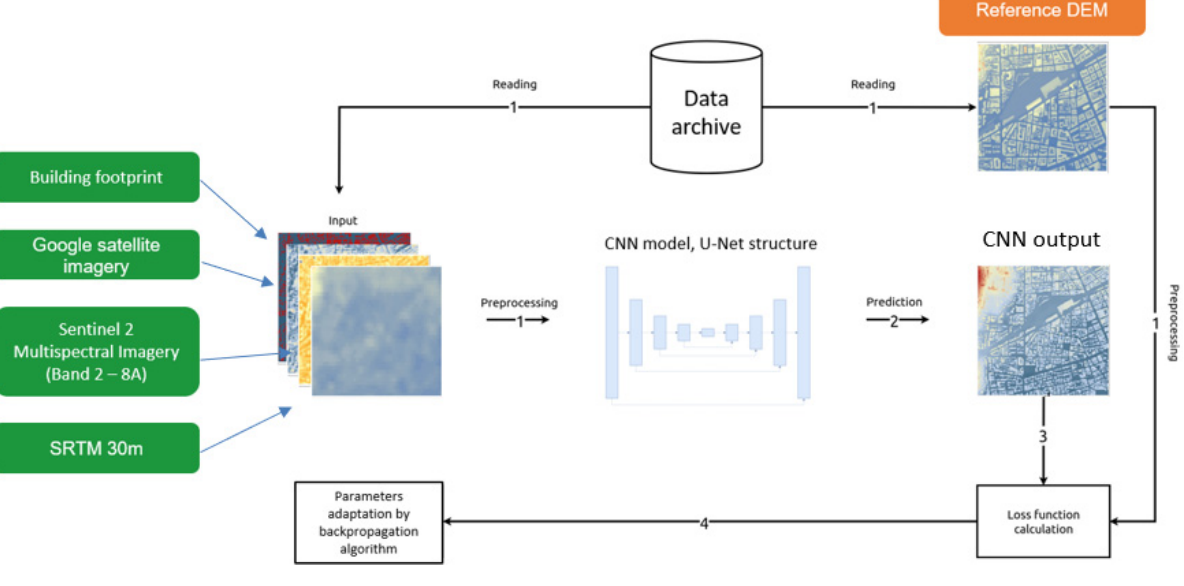
Figure 4. The structure of the CNN model.